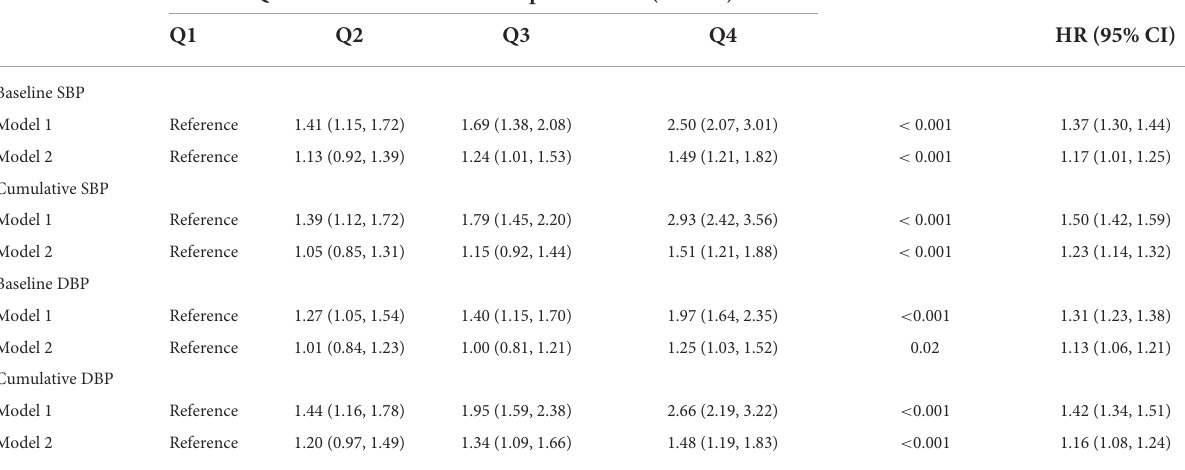
TABLE 2 Association between intensity of hypertensive exposure and coronary artery calcium. Quartile of cumulative blood pressure HR (95% CI) P for trend Per SD